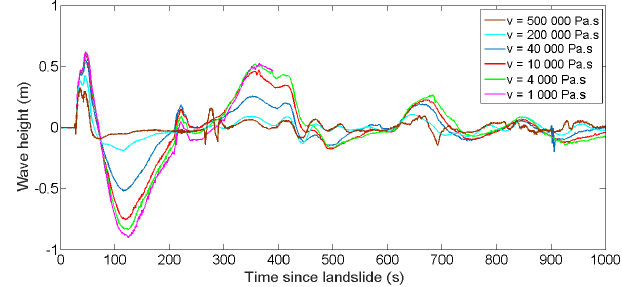
Figure 7. Time series calculated at the synthetic gauge G 1 as a func- tion of time for the dynamic viscosities v tested here.